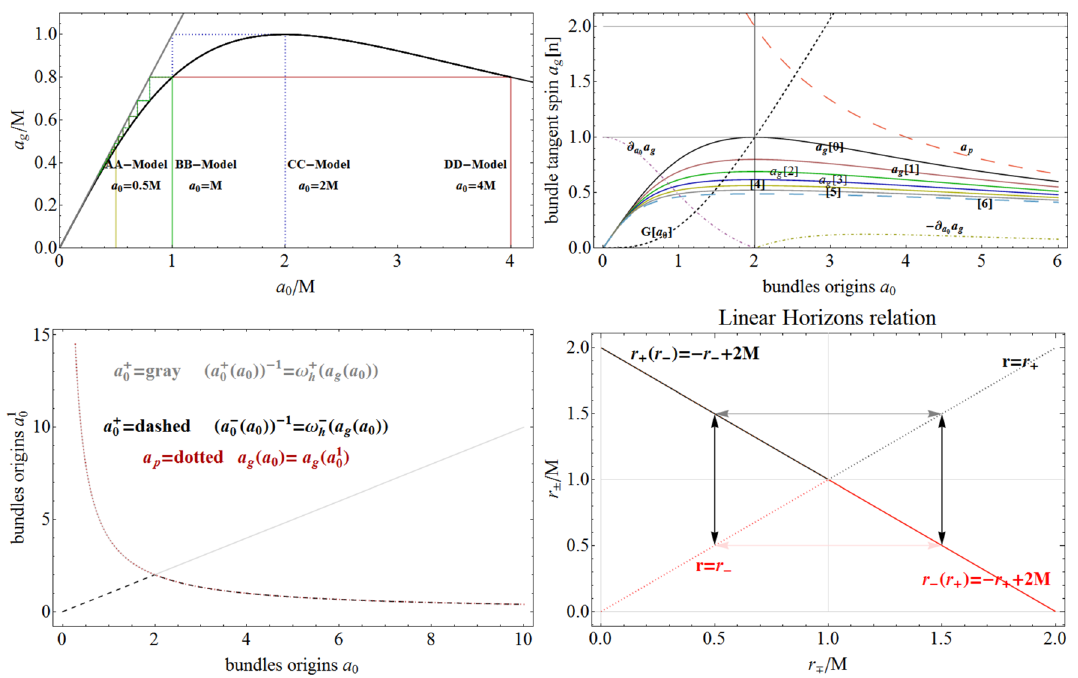
Fig. 14 Below right panel: the functions r − ( r + ) (red line) and r + ( r − ) a g [ n ] as function of the starting points a 0 . BD bundles have coincident (black line) (on the lines a =constant of the extended plane). The region cycles ( BB and DD ) with the exception of the initial point; BB-CC bun- r ± × r ∓ ∈ [ 0 , 2 M ] × [ 0 , 2 M ] describes BH horizons in the extended dles have partially coincident cycles. Cycles (with the exclusion of the initial point a 0 ) are entirely confined in the BH region. Models XX with plane along the red and black lines or, equivalently, the dotted lines, X = { A , B , C , D } are defined in Fig. 15. For a fixed a 0 , a g [ n ] decreases according to the symmetries enlightened in the plot. Below left panel: with the number of cycles. The importance of the bundle with origin / M = 2 r ± ( a g ) the solutions a ± as functions of bundle origin a 0 ; they 0 a g a 0 = 2 M is also shown; this is related to the extreme Kerr BH and correspond to a = a 0 and a = a p , i.e., a g ( a 0 ) = a g ( a p ) and there is a maximum for each cycle; a 0 = 2 M is the fixed point of the ≡ a ± / M = 2 r ± ( a g ) ≡ ω − 1 ( a ) , determining the related BC or ω − 1 g transformation a 0 = a p . The difference G [ a 0 ] ≡ a 0 − a g increases H 0 0 a g BD bundles – Table 2. Upper panels: Recurrence relation for the point reaching G [ 2 M ] = 1 M = 2 M − a g only for the first cycle – Table 2